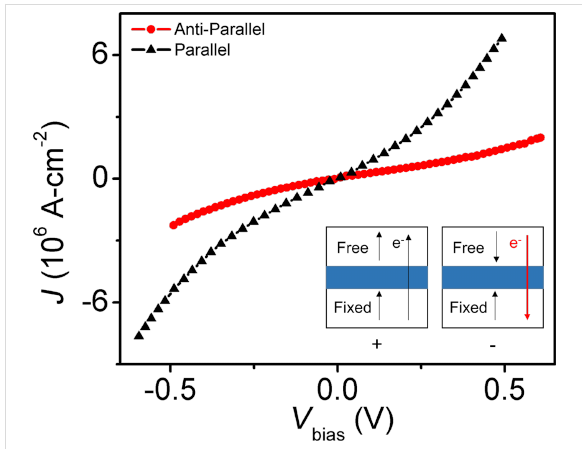
Figure 2: Characteristic J – V curve built from literature [4-7] with simi- lar CoFeB/MgO/CoFeB MTJ with thickness of the order of a few nano- meters. Probes are used to find bias voltage across the tunnel junc- tion. Curves are extrapolated via nearest-function method for 0.6 V simulations. Insets show the flow of carriers, and implied material prop- erties, for a given initial free and fixed magnetic layer alignment. Simu- lations with initially parallel (ON) free/fixed layers use parallel proper- ties, whereas simulations with initially anti-parallel (OFF) free/fixed layers use anti-parallel